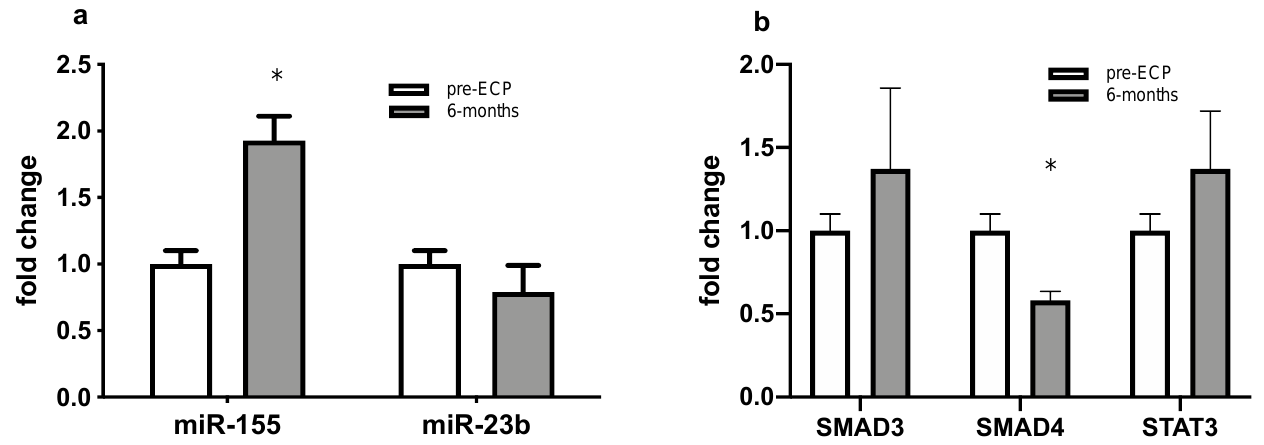
Figure 4. Quantitative expression of ( a ) miR-155 and miR-23b and ( b ) SMAD3, SMAD4 and STAT3 assessed by qRT-PCR in PBMCs of BOS patients. * p < 0.05.